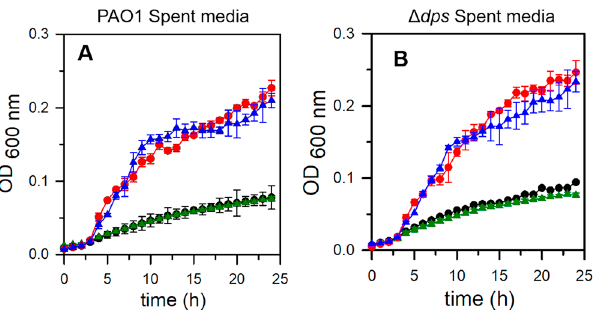
Figure 11. Pa Dps does not contribute to the utilization of DNA as a nutrient source. PAO1 (black), PAO1 + DNA (red), Δ dps (green), Δ dps + DNA (blue). The growth of PAO1 or Δ dps cells in spent media obtained from culturing PAO1 ( A ) or Δ dps ( B ) cells is aided similarly by the presence of DNA as a nutrient source. Each of the growth curves was constructed from the average and standard deviation of 3 replicate wells.